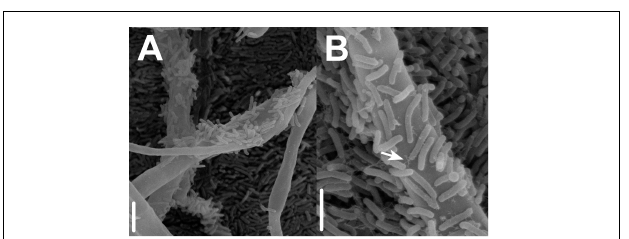
FIGURE 2 | Scanning electron micrographs presenting details on close synergistic fungal–bacterial physical interactions under oligotrophic conditions during interaction bioassays. (A) Prokaryotic ( Aeromonas sp. 1) accumulation on the surface of fungal hyphae ( Coprinellus micaceus 1). (B) Bacterial production of fibrous adhesive material (arrow) and attachment to fungal hyphae; bars = 10 µ m in A , 5 µ m in B